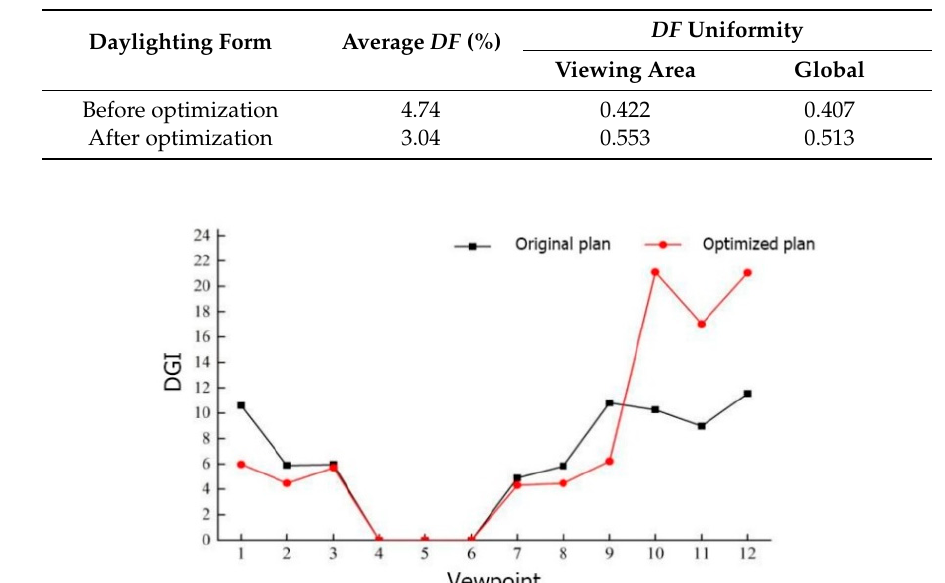
Figure 14. Optimization of high side windows of the exhibition hall: ( a ) back side view; ( b ) front side view. Table 4. The DFs and DF uniformity values of the daylighting scheme using a high side window before and after optimization.